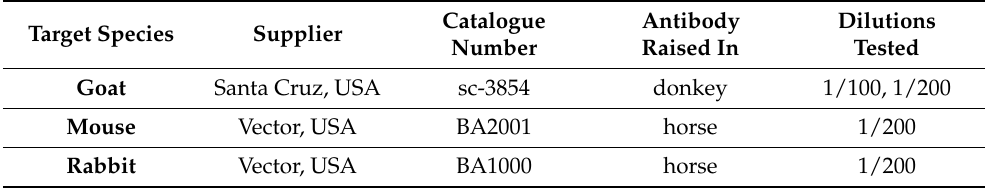
Table 5. Secondary antibody reagents for rat and pig